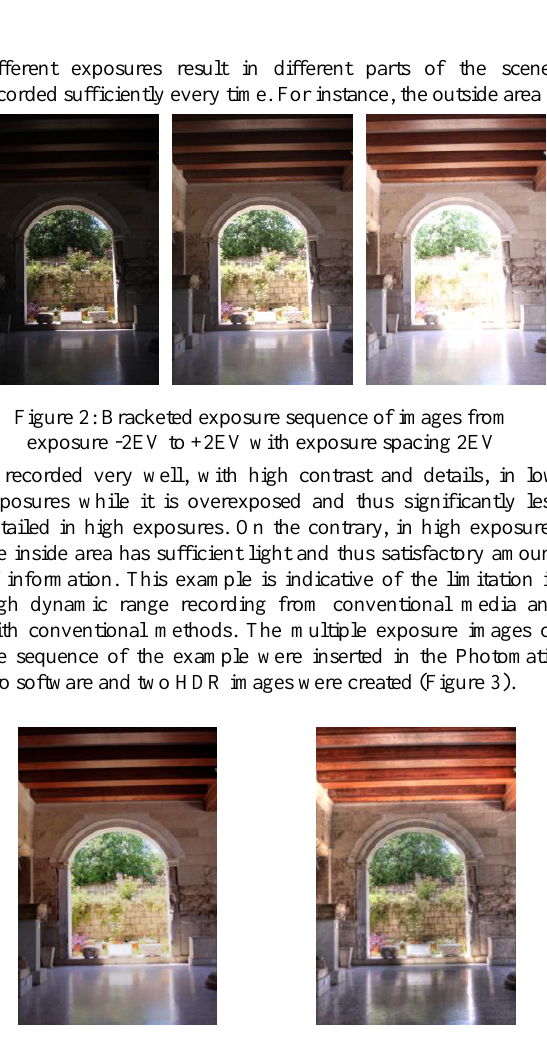
Figure 3: HDR images of the sequence of Figure 2, tone mapped with global (left) and local (right) operator